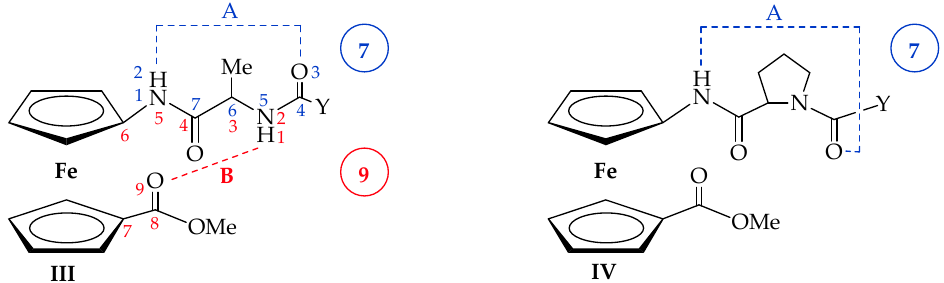
Figure 2. The asymmetrically disubstituted peptidomimetics ( III ) and ( IV ) containing turn-inducing ferrocene template -NH-Fn-CO- (Y = Boc or Ac).